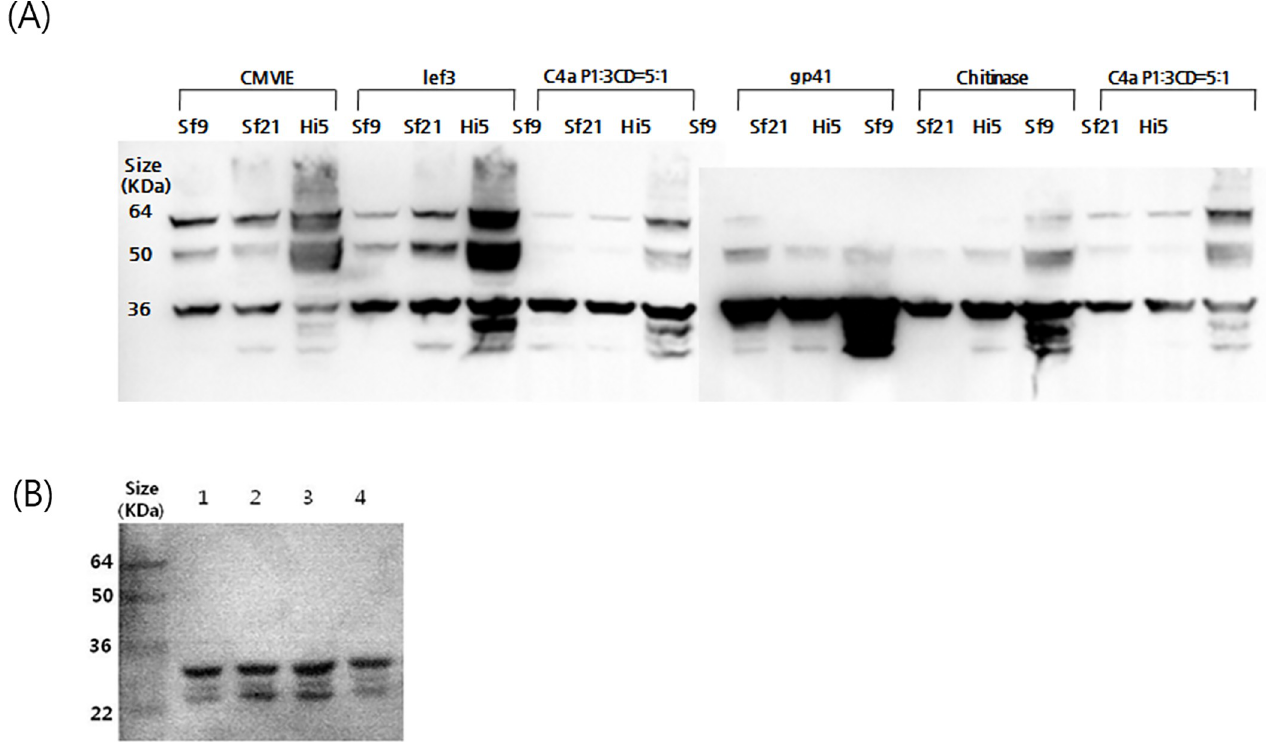
Fig 1. Western blot analysis of cell lysates infected by the Baculo-P1-3CD-gp41 construct. The proteins were separated by SDS-PAGE, electrotransferred to a nitrocellulose membrane, and probed using anti-VP2 MAb (MAb979) as the primary antibody (A). Hi-5 cells used for EV71 VLP large-scale production were infected with Baculo-P1-3CD-gp41 at MOI 5, and protein was analyzed using an anti-VP1 Mab produced in-house (B). Lane1: Baculo-P1-3CD- CMV-IE infected cell lysates; Lane2: Baculo-P1-3CD-lef3 infected cell lysates; Lane3: Baculo-P1-3CD-gp41 infected cell lysates; Lane4: Baculo-P1-3CD-chitinase infected cell lysates. The cells were harvested from 3